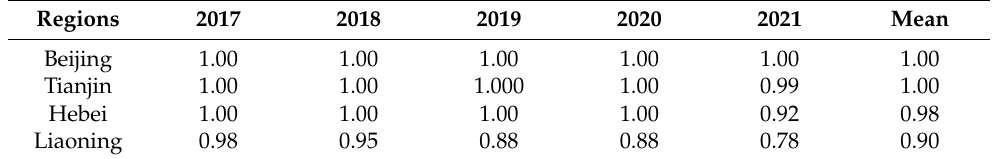
Figure 3. Pure technical efficiency implementation management of green buildings during 2017–2021. Table 4. Pure technical efficiency implementation management of green buildings during